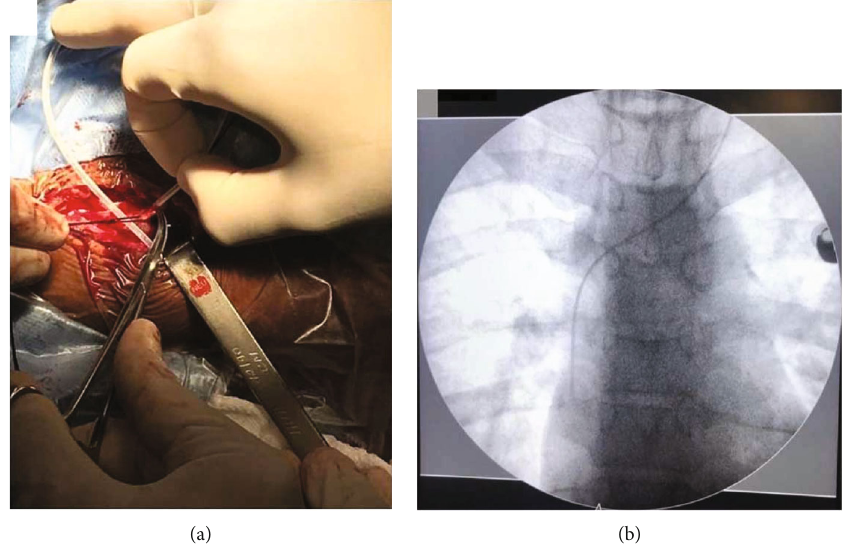
Figure 5: Distal catheter insertion. (a) Insertion of the distal catheter in the right atrium through the left linguofacial trunk. (b) Chest X-ray con fi rming atrial catheter